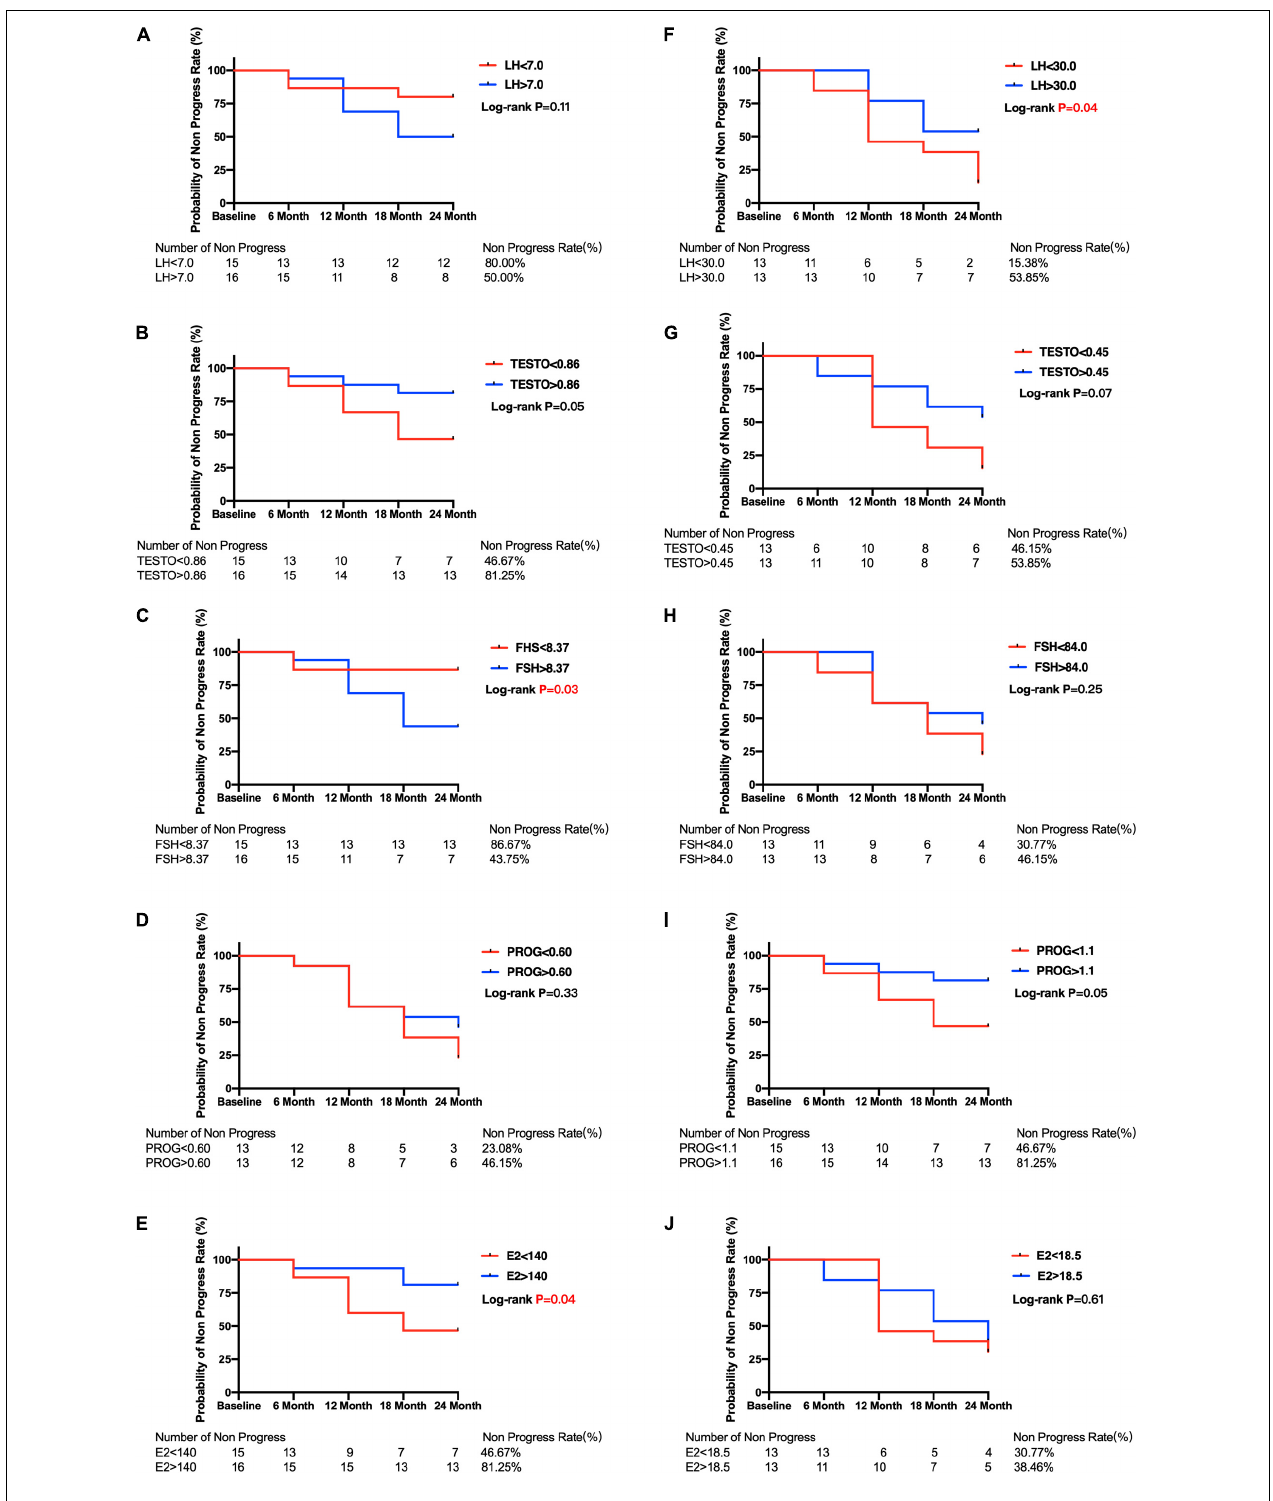
FIGURE 4 | Kaplan–Meier curves for primary open angle glaucoma patients between subgroups divided by menopause or median of sex hormone level. Plots of Kaplan–Meier depicts the probability of no progression in POAG patients in each group. The number of POAG patients without progression in each group were shown below five follow-up time points. Kaplan–Meier curves between lower and higher baseline level of LH (A) , TESTO (B) , FSH (C) , PROG (D) , E2 (E) in premenopausal and LH (F) , TESTO (G) , FSH (H) , PROG (I) , E2 (J) in postmenopausal POAG subjects. PRL, prolactin; LH, luteinizing hormone; TESTO, testosterone; FSH, follicle-stimulating hormone; PROG, progesterone; E2, 17- β -estradiol.